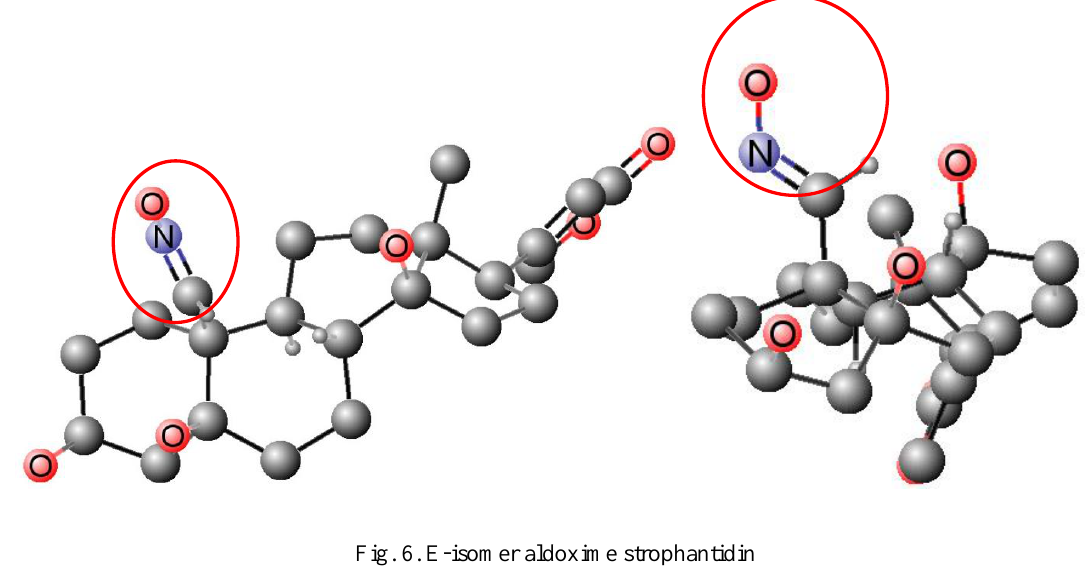
Fig. 6. E-isomer aldoxime strophantidin